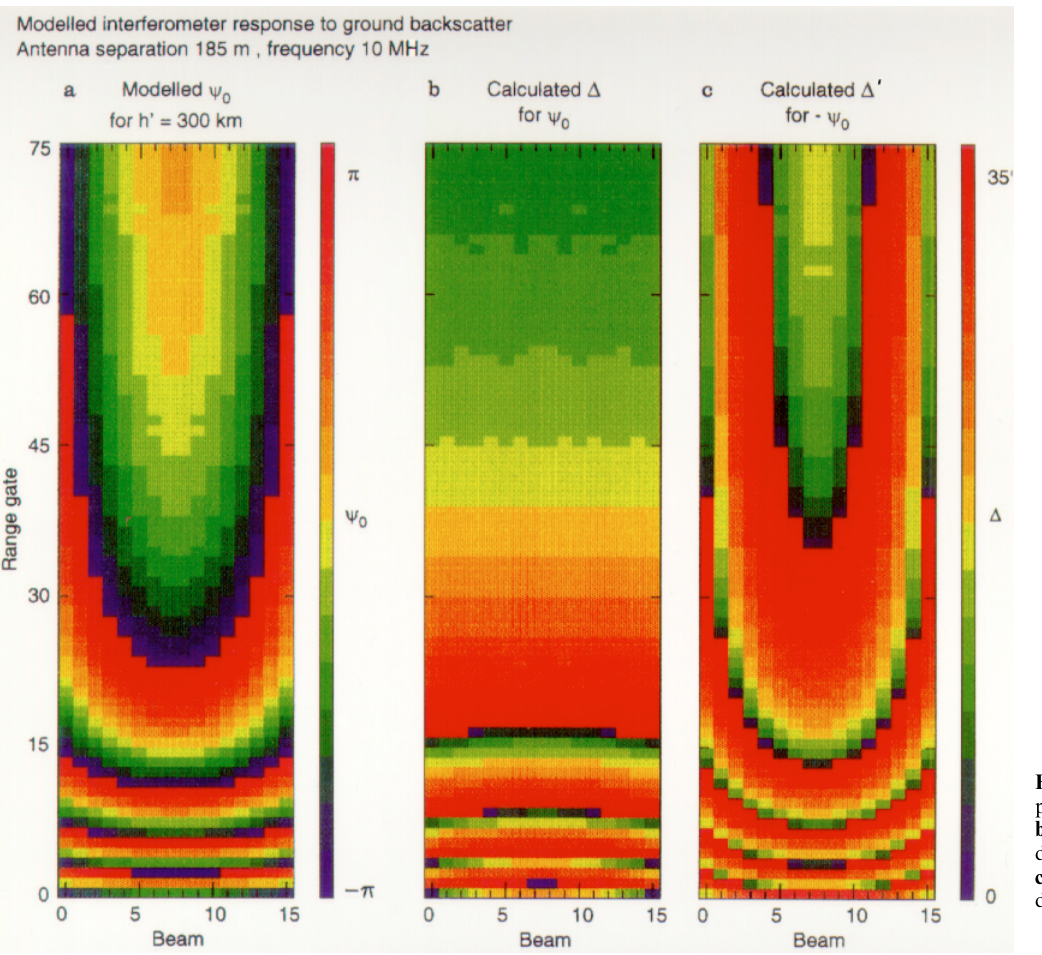
Fig. 4. a Modelled phase lag, (cid:87) (cid:48)